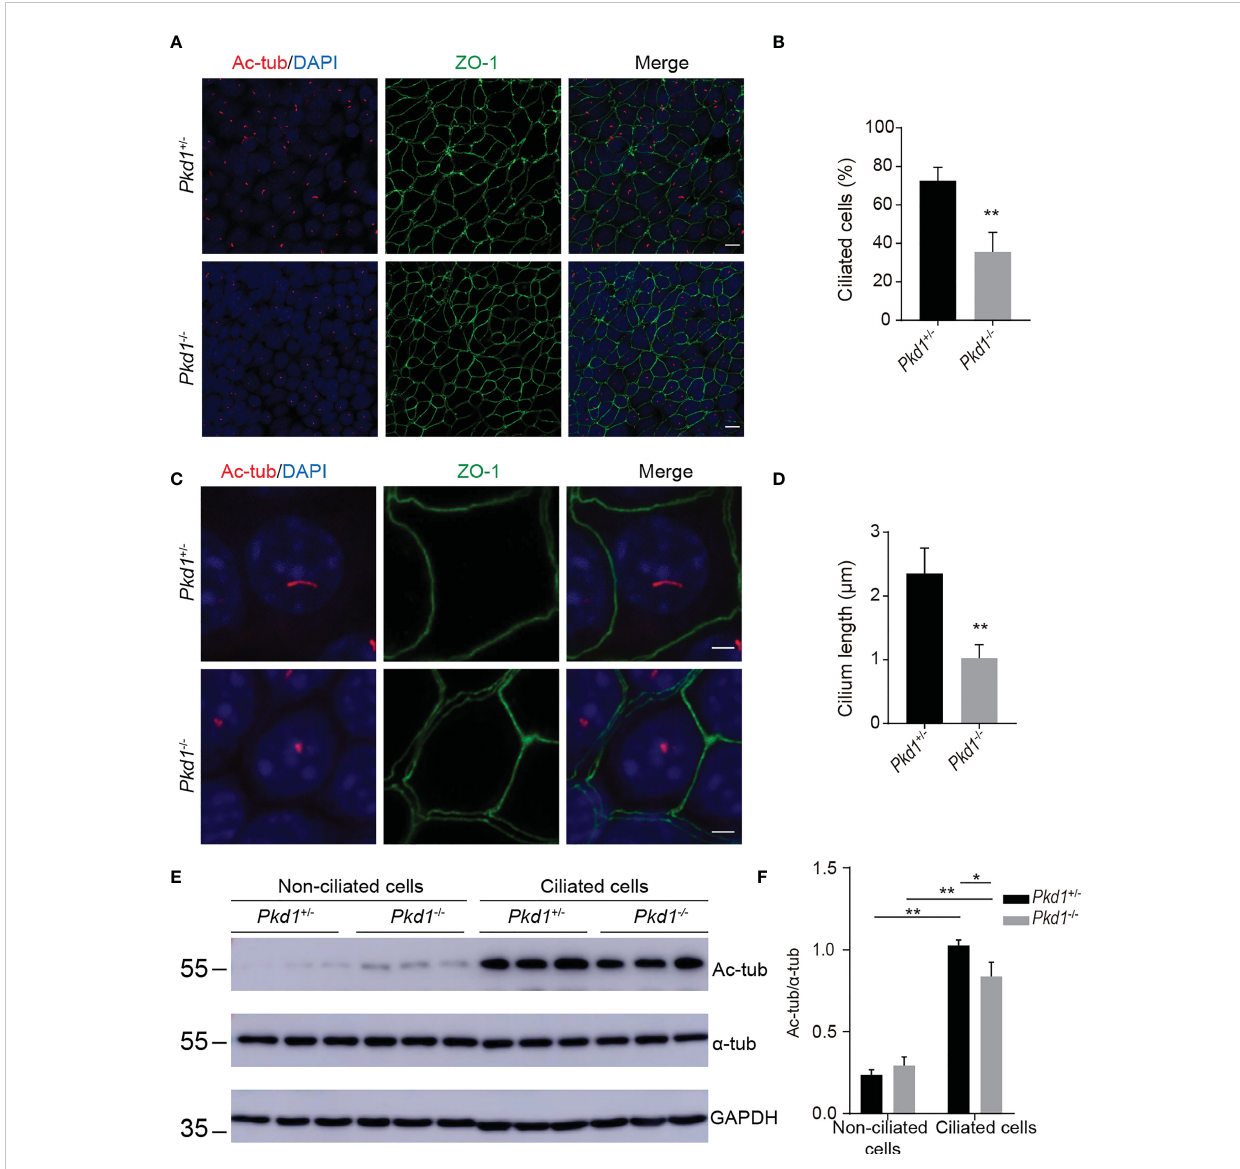
FIGURE 2 Compromised ciliary integrity in Pkd1 -depleted mouse kidney tubule cells. (A) Immuno fl uorescence images of homozygous or heterozygous Pkd1- knockout cells. Cilia and tight junctions were stained with acetylated a -tubulin (red) and ZO-1 (green), respectively. Nuclei were stained with